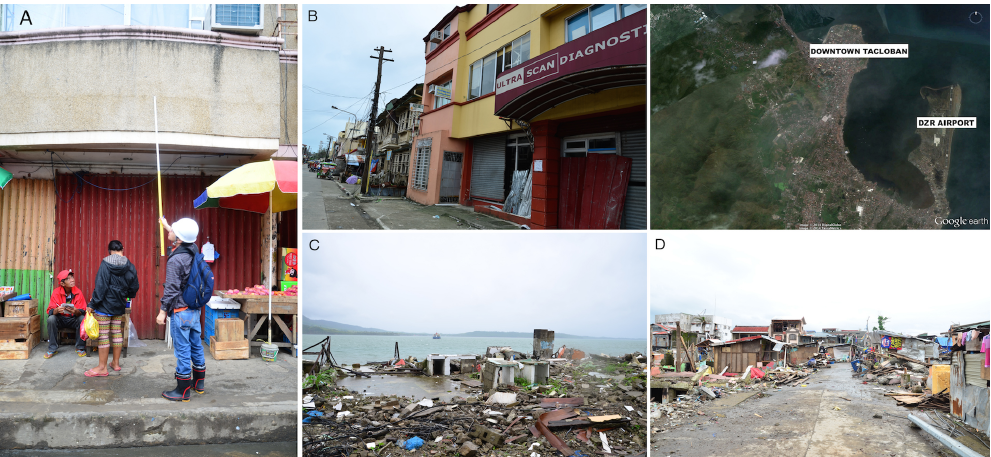
Figure 10. (a) Watermark in the inland downtown area, where no structural damage was observed. (b) Inland downtown, damage to doors due to flooding. (c, d) Extensive damage at the coastline near downtown